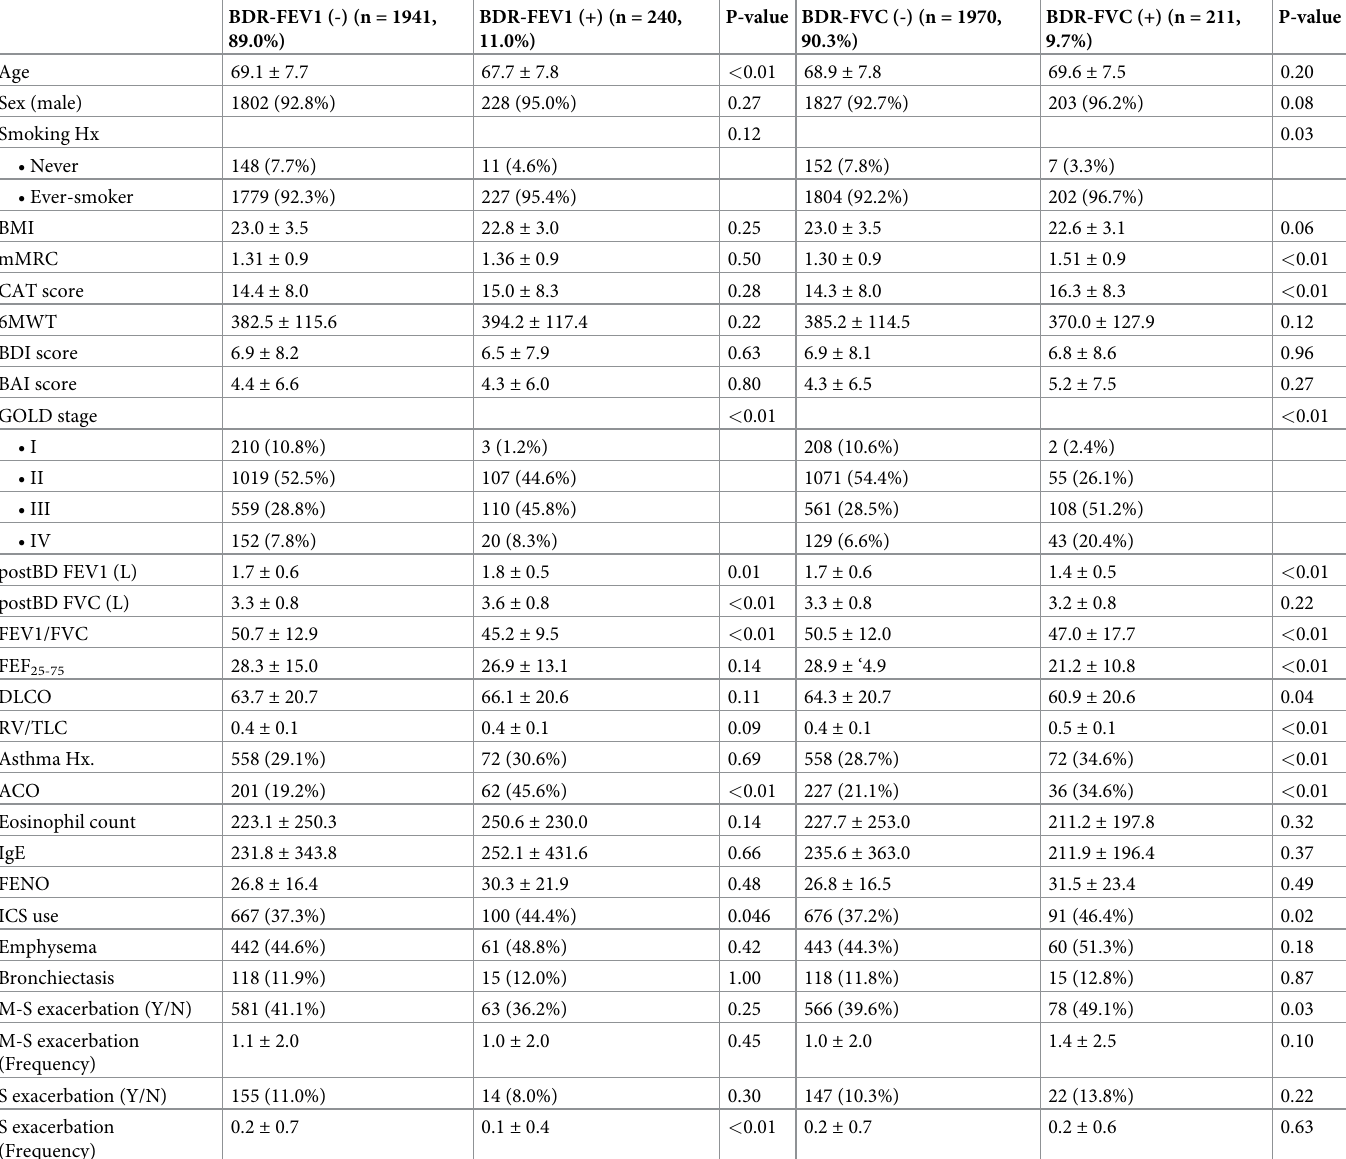
Table 2. Differences of clinical characteristics according to bronchodilator response defined by FEV1 response and FVC response. BDR-FEV1 (-) (n = 1941,